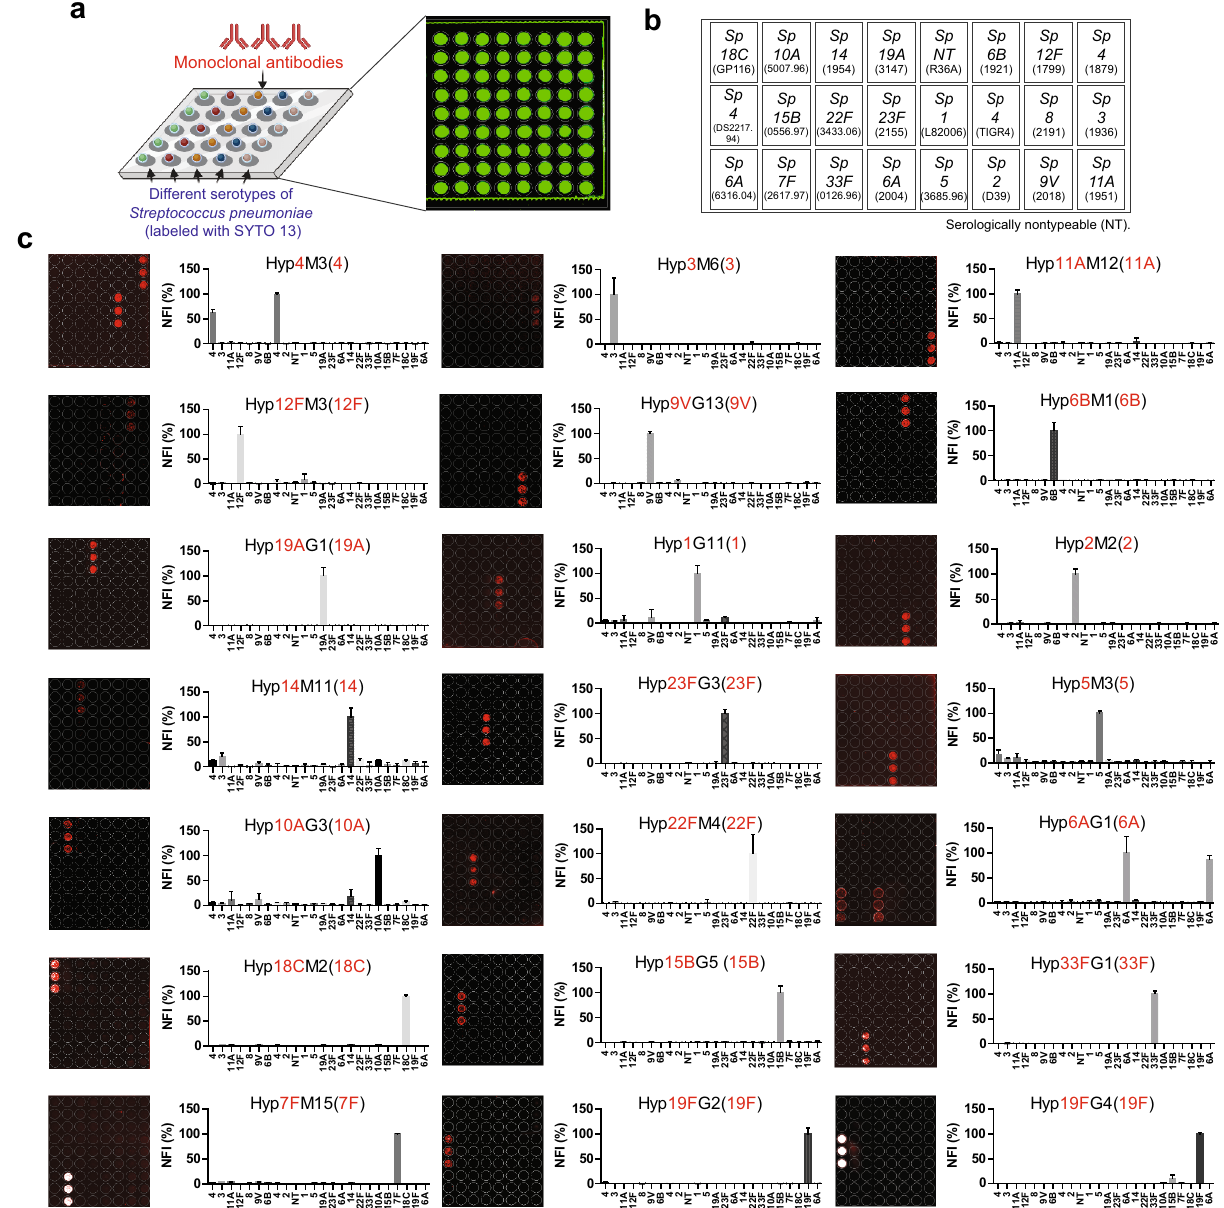
Figure 4. Validation of MMA using defined monoclonal antibodies. ( a ) Schematic overview for the MMA. Bacteria labeled with SYTO 13 were printed to the nitrocellulose glass slide, and serotype specific monoclonal antibodies were then added to the microarray following Alexa Fluor 647 conjugated secondary antibody detection. ( b ) Printing layout of MMA. Isolated S. pneumoniae without a capsule was defined as serologically nontypeable (NT). 89 Serotypes were shown and strain name is labeled in the parentheses. ( c ) Left panel of each figure indicate images of fluorescent signals observed on the microarray. Their corresponding targeted serotype of each antibody was labeled in red. All fluorescent intensities were normalized by the highest intensity value and shown as Normalized fluorescent intensity (NFI). Data shown correspond to the mean of triplicate spots and error bars represent means ±